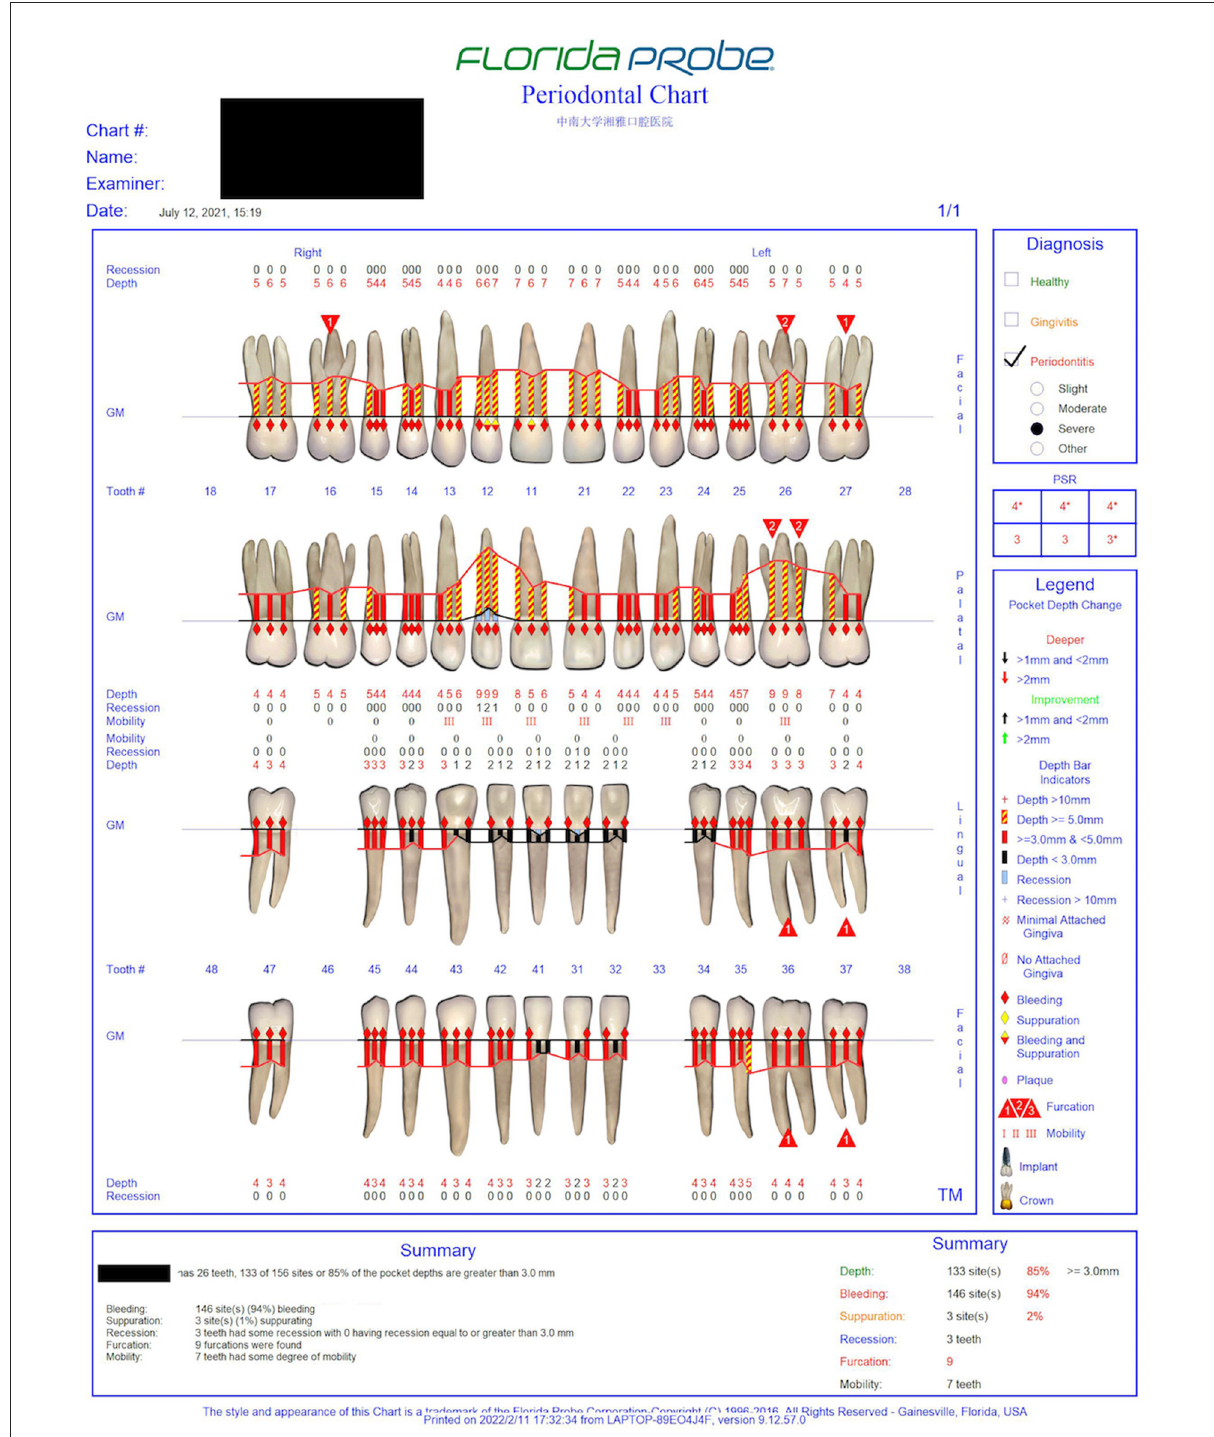
FIGURE2 The proband’s periodontal chart at the initial consultation.